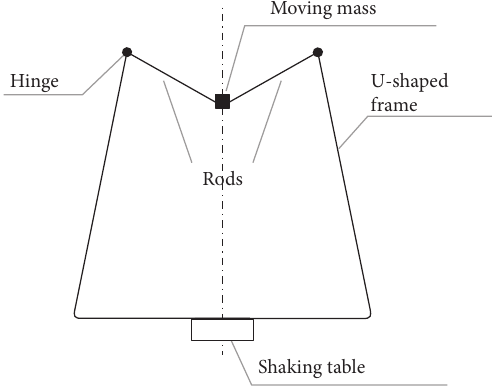
Figure 1: Schematic representation of the negative stiffness oscillator.